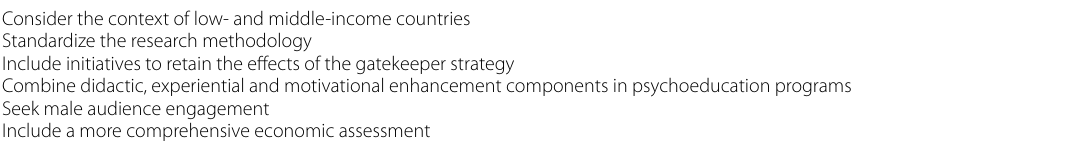
Table 6 Research priorities to promote evidence-based suicide prevention practices in